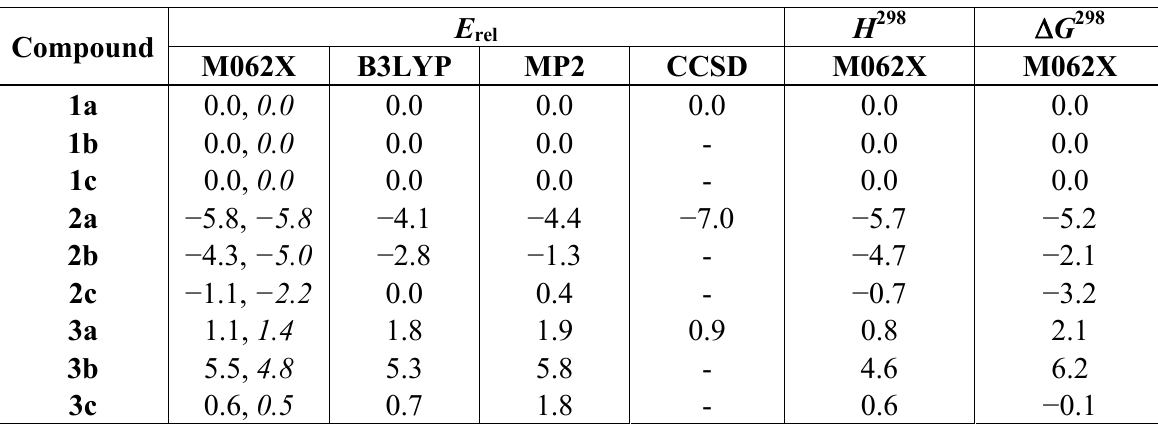
Table 1. Calculated relative energies of silaphenolates 1a – 3c a